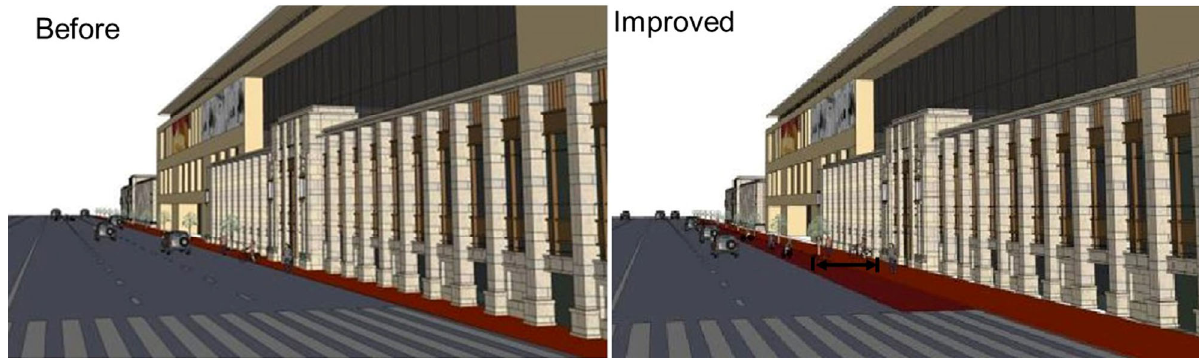
Figure 16. Comparison of the road environment.